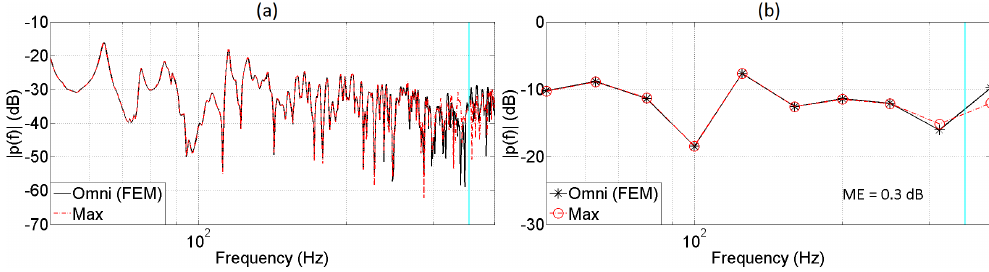
Figure 21. Comparison of full ( a ) and 1/3 octave band ( b ) frequency responses. Translated PWE and omnidirectional room impulse response (FEM) at translated Position